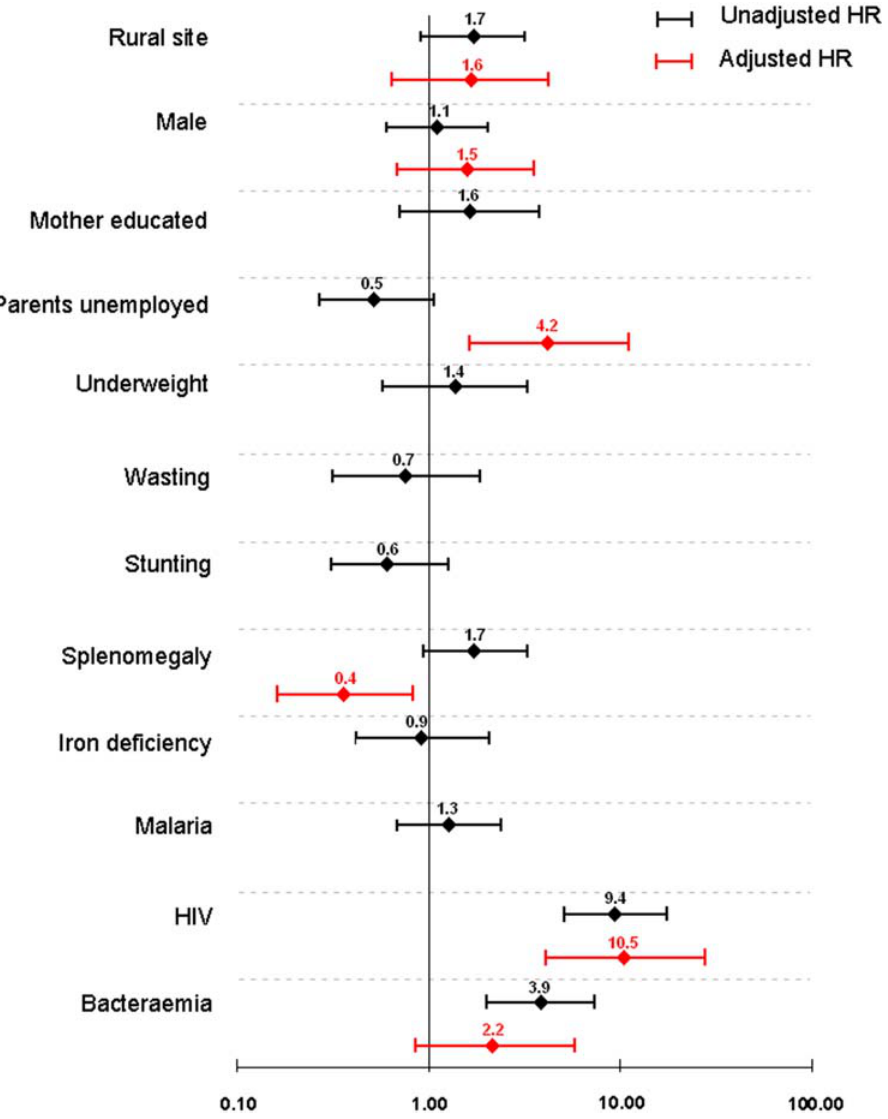
Figure 2. Unadjusted (in black) and adjusted (in red ) Hazard Ratios of main risk factors for post-discharge all cause mortality among severely anaemic children ( cases ).